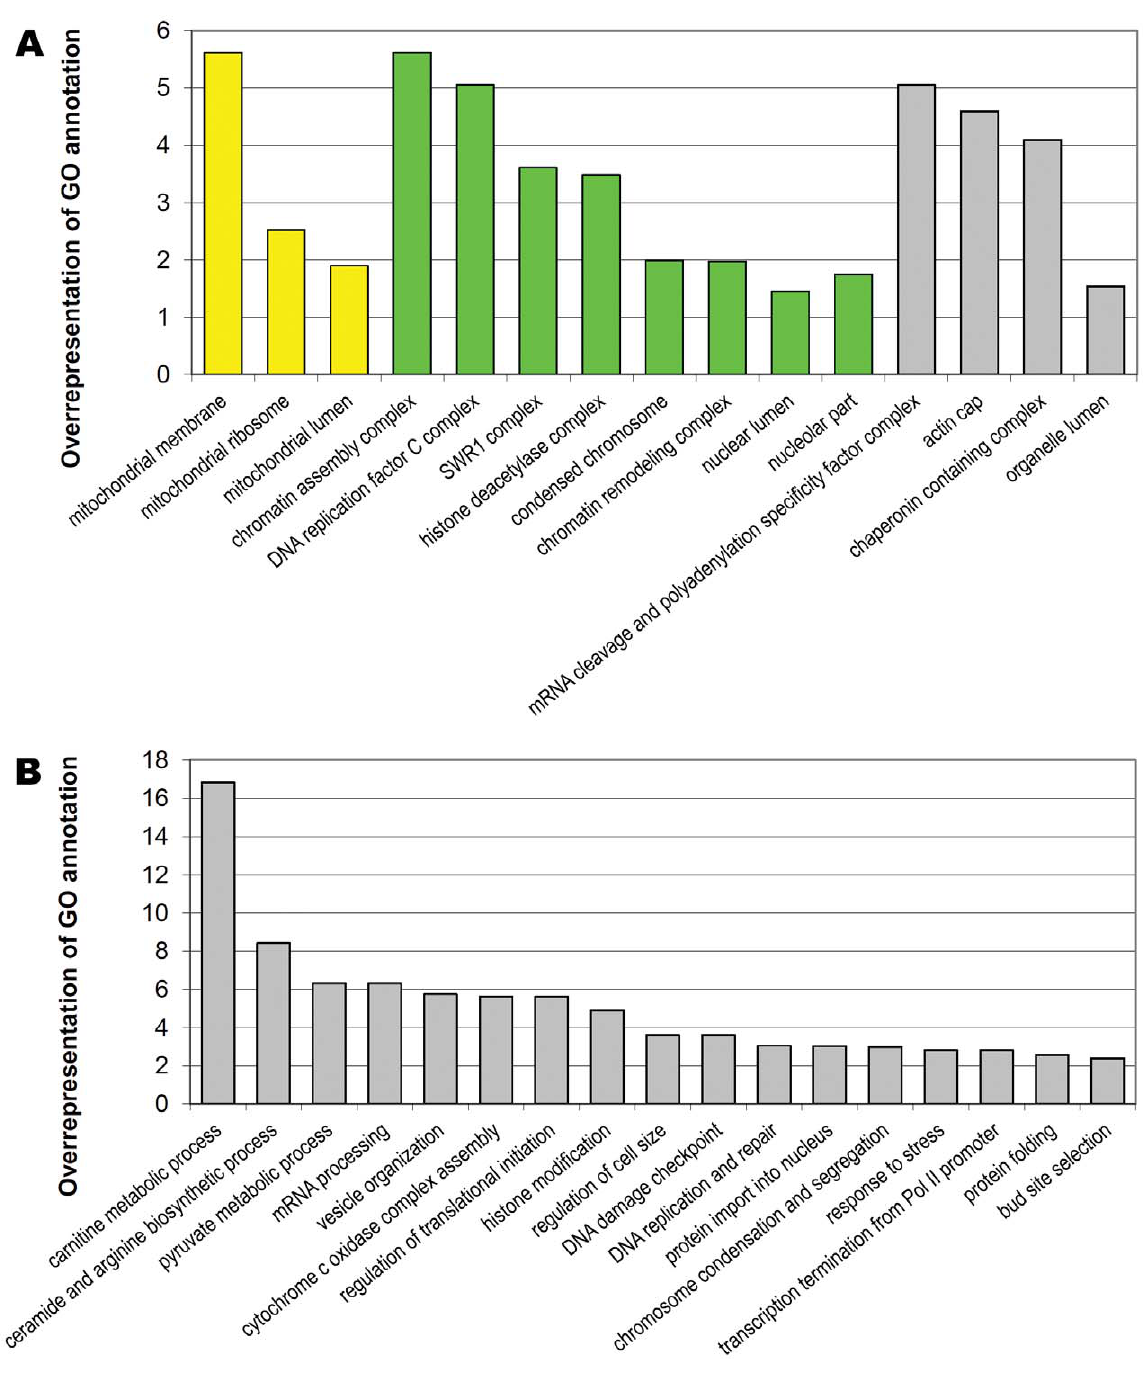
Figure 7. Overrepresentation of GO annotations in the group of 249 genes selected in genomic SLM screen. The analysis of overrepresentation of Gene Ontology annotations in the group of 249 genes selected in our large scale SLM screen was done with the help of GeneMerge on-line tool (http://genemerge.cbcb.umd.edu/); e , 0.1. A) Overrepresentation of Cellular Component annotations. Annotations pertaining to nucleus are shown in green whereas those pertaining to mitochondria are shown in yellow. B) Overrepresentation of Biological Process annotations.